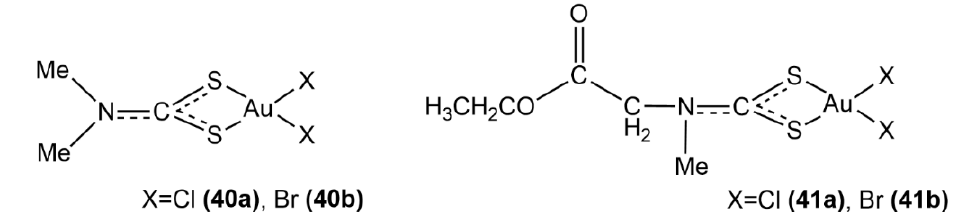
Figure 18. Au(III) complexes with dithiocarbamates ( 40a , 40b , 41a , 41b ).